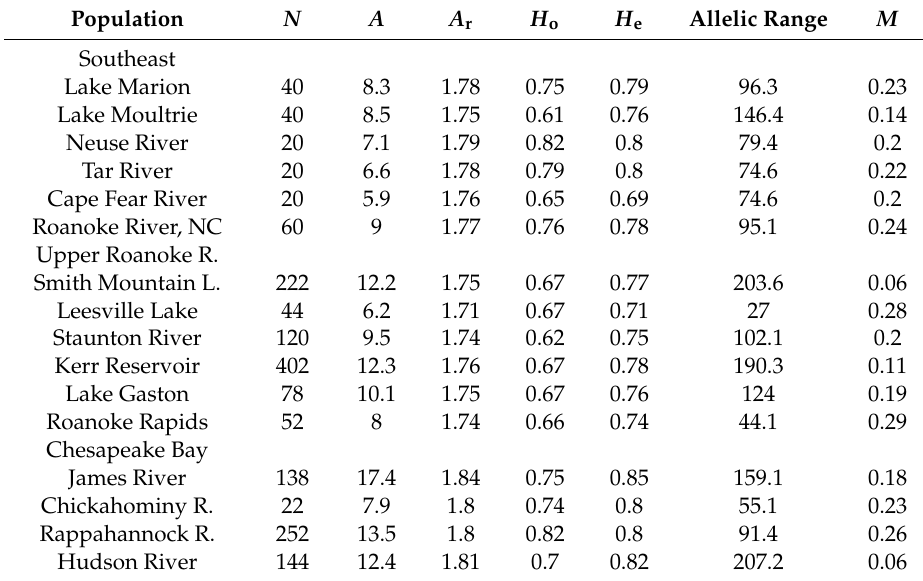
Table 3. Microsatellite DNA diversity in striped bass collections. N = number sampled, A = mean number of alleles per locus, A r = allelic richness, H o = mean observed heterozygosity, H e = mean expected heterozygosity, allelic range = mean di ff erence between sizes of largest and smallest alleles at a particular locus, M = ratio of number of alleles observed at a locus to number of alleles possible between the largest and smallest alleles